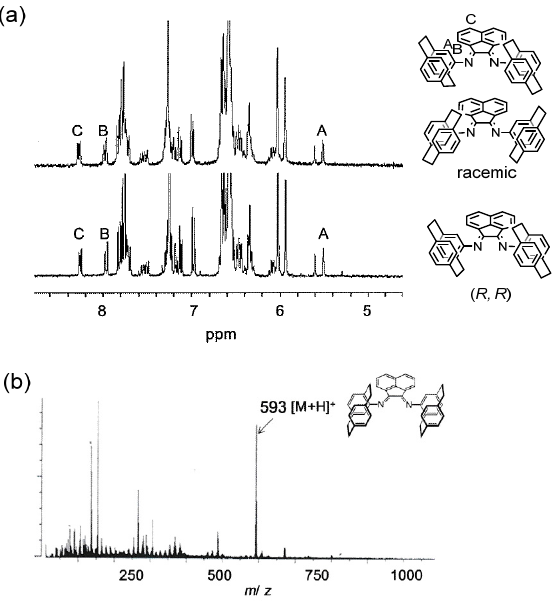
Figure 1. ( a ) 1 H NMR spectra (aromatic hydrogen region) of ligand L1 obtained from racemic amino[2.2]paracyclophane (upper) and from the optically amino[2.2]paracyclophane (lower). ( b )